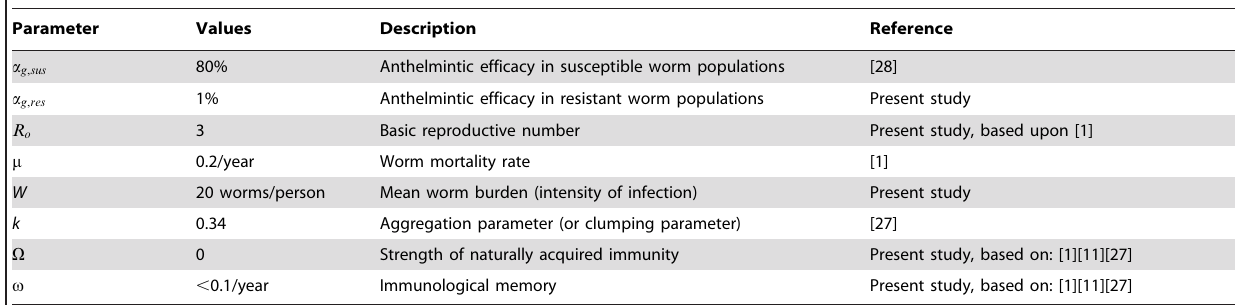
Table 1. Baseline parameters for the model.